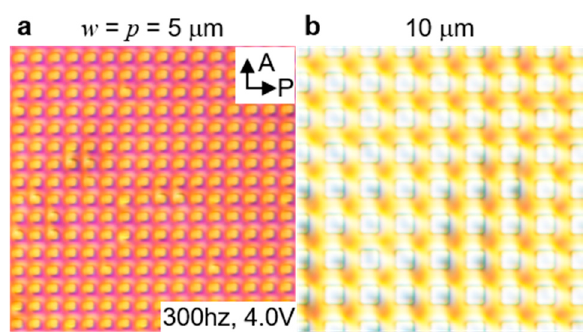
Figure 7. Effect of cell thickness on the defect formation with respect to pillar width w and pillar spacing p : ( a ) w = p = 5 µ m; and ( b ) w = p = 10 µ m. Cell thickness d = 11 µ m, pillar height h = 2 µ m. P, polarizer; A, analyzer; λ , full-wave plate.